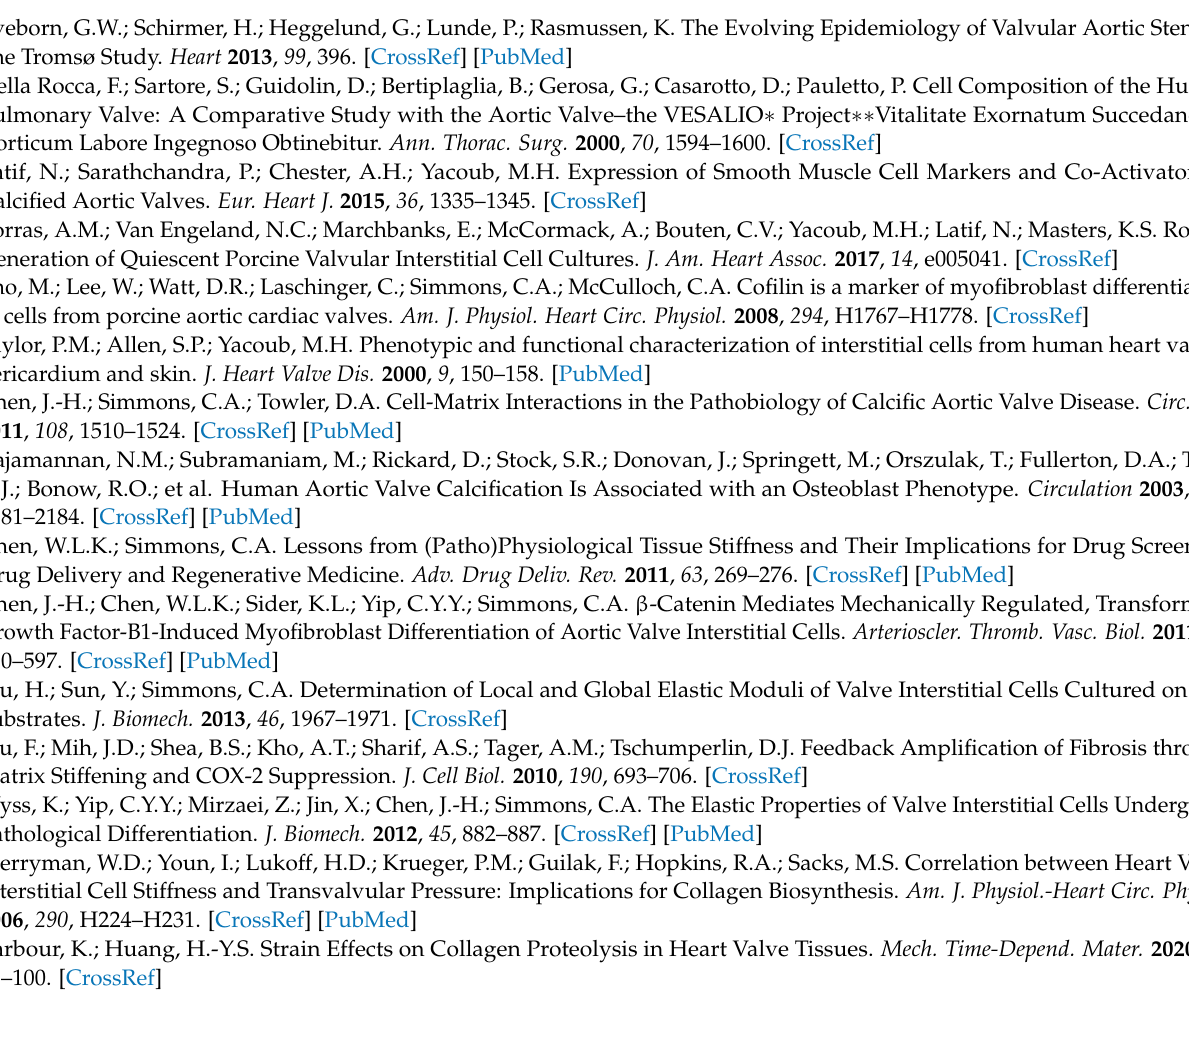
Figure S5: Representative fields comparing α -SMA staining of glass and CNT-interfaced